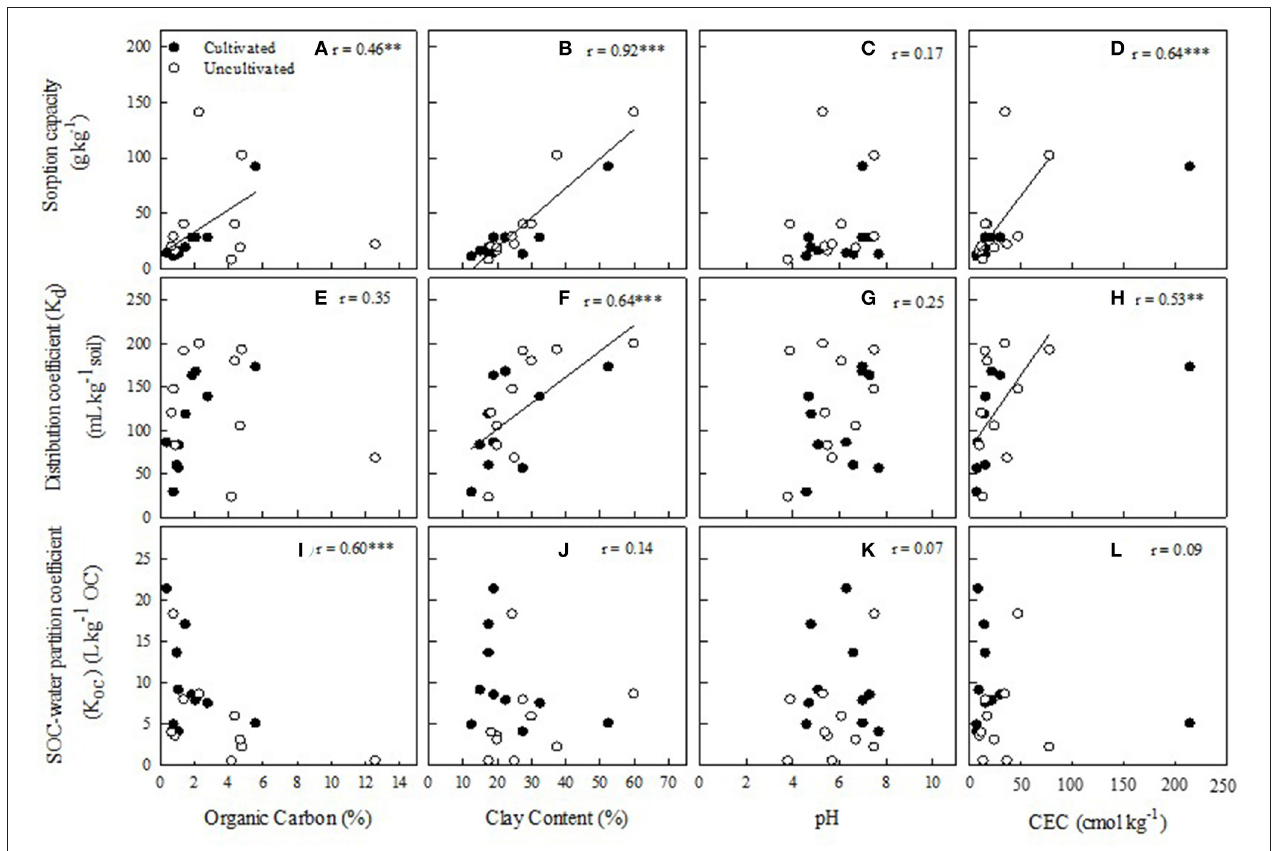
FIGURE 3 | Relationships between selected soil properties and ciprofloxacin sorption parameters. Soil 18 from Table 1 was excluded from correlation analysis for subplots (A,E,I) , while Soil 16 from Table 1 was excluded from correlation analysis for subplots (D,E,L) . Linear regression is significant ( p < 0.01) for (B,E) and ( p < 0.05) for (A)